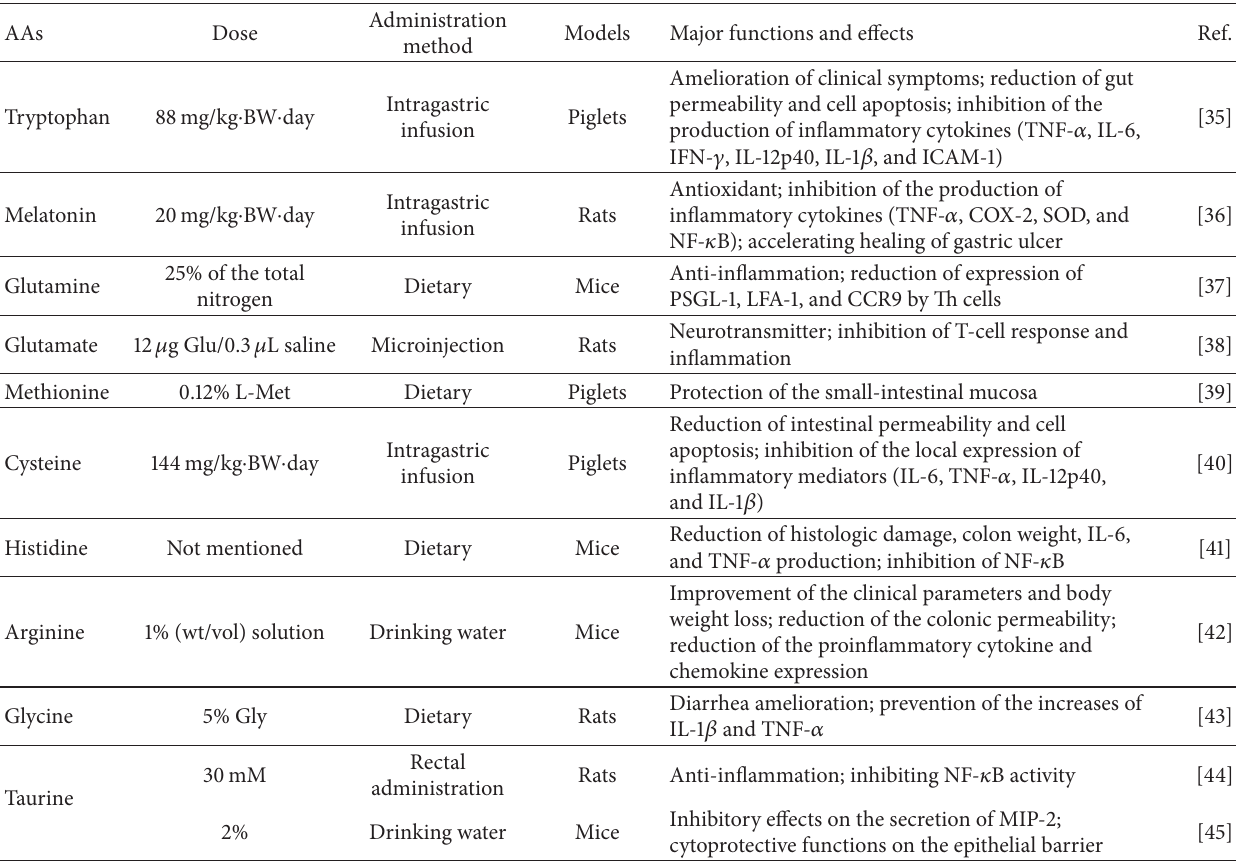
Table 2: Application of partial AAs in inflammatory bowel disease